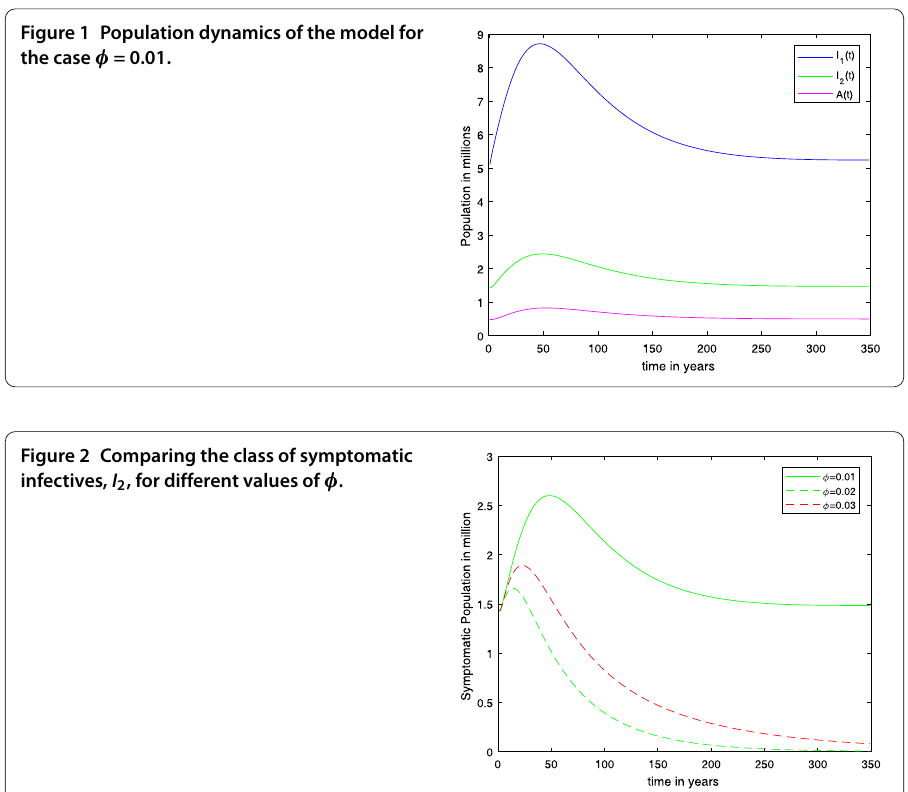
Figure 2 Comparing the class of symptomatic infectives, I 2 , for different values of φ